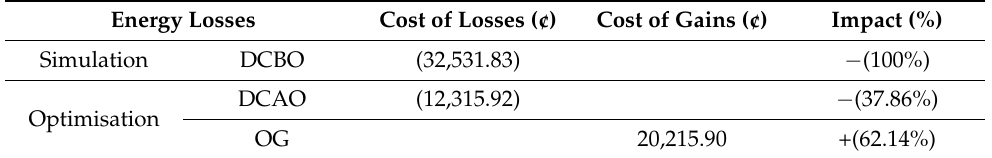
Table 8. Summarising Losses Cost of Comparison.